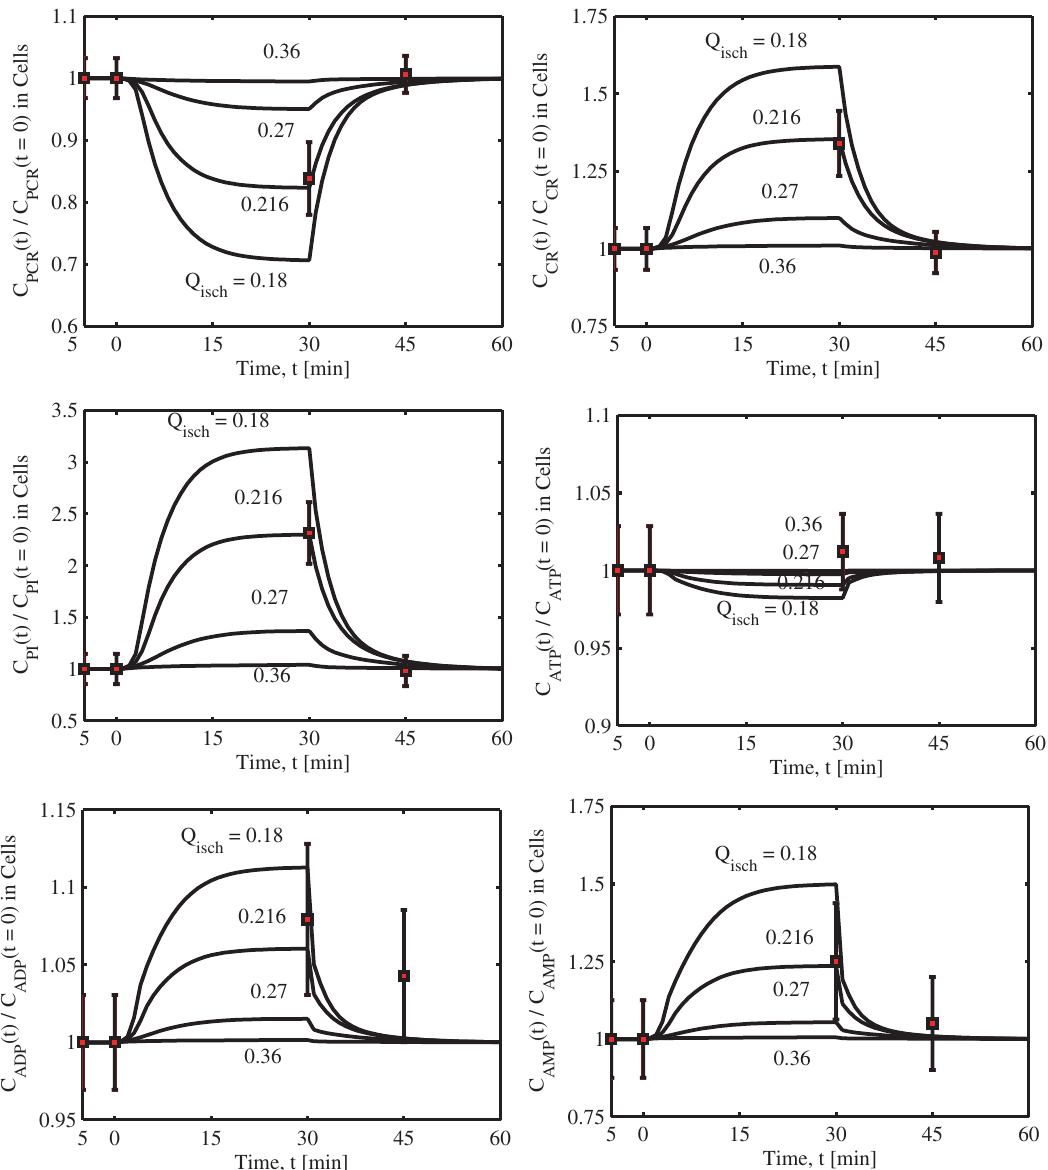
Figure 4. Model-predicted dynamic responses of energy metabolite concentrations in the muscle tissue cells during the resting, ischemia and recovery periods with varying levels of blood flow reductions and their comparison to the experimental data of Katz [ 22 ] . The lines represent the model simulation results with the symbols representing the experimental data points (mean 6 SD) corresponding to Q isch =0.216 L/min ( , 76% blood flow reduction). The simulation strategy, ischemia protocol, and blood flow reduction levels are exactly the same as those described in the caption of Figure 3. The metabolites concentrations are shown in normalized form, normalized with respect to the resting metabolites concentrations. The concentrations in the tissue cells were calculated based on the formula: C cl =( V cyt C cyt + V mit C mit )/ V cl .